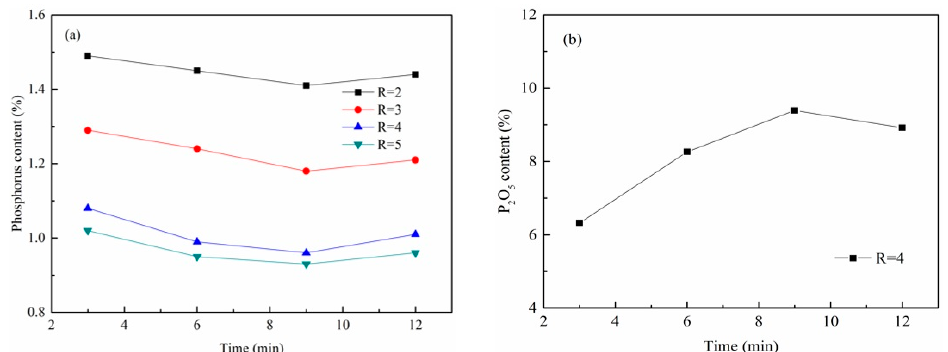
Figure 10. Effect of basicity on the dephosphorization of the reduced iron: ( a ) phosphorus content of the molten iron; and ( b ) P 2 O 5 content of the dephosphorization slag.